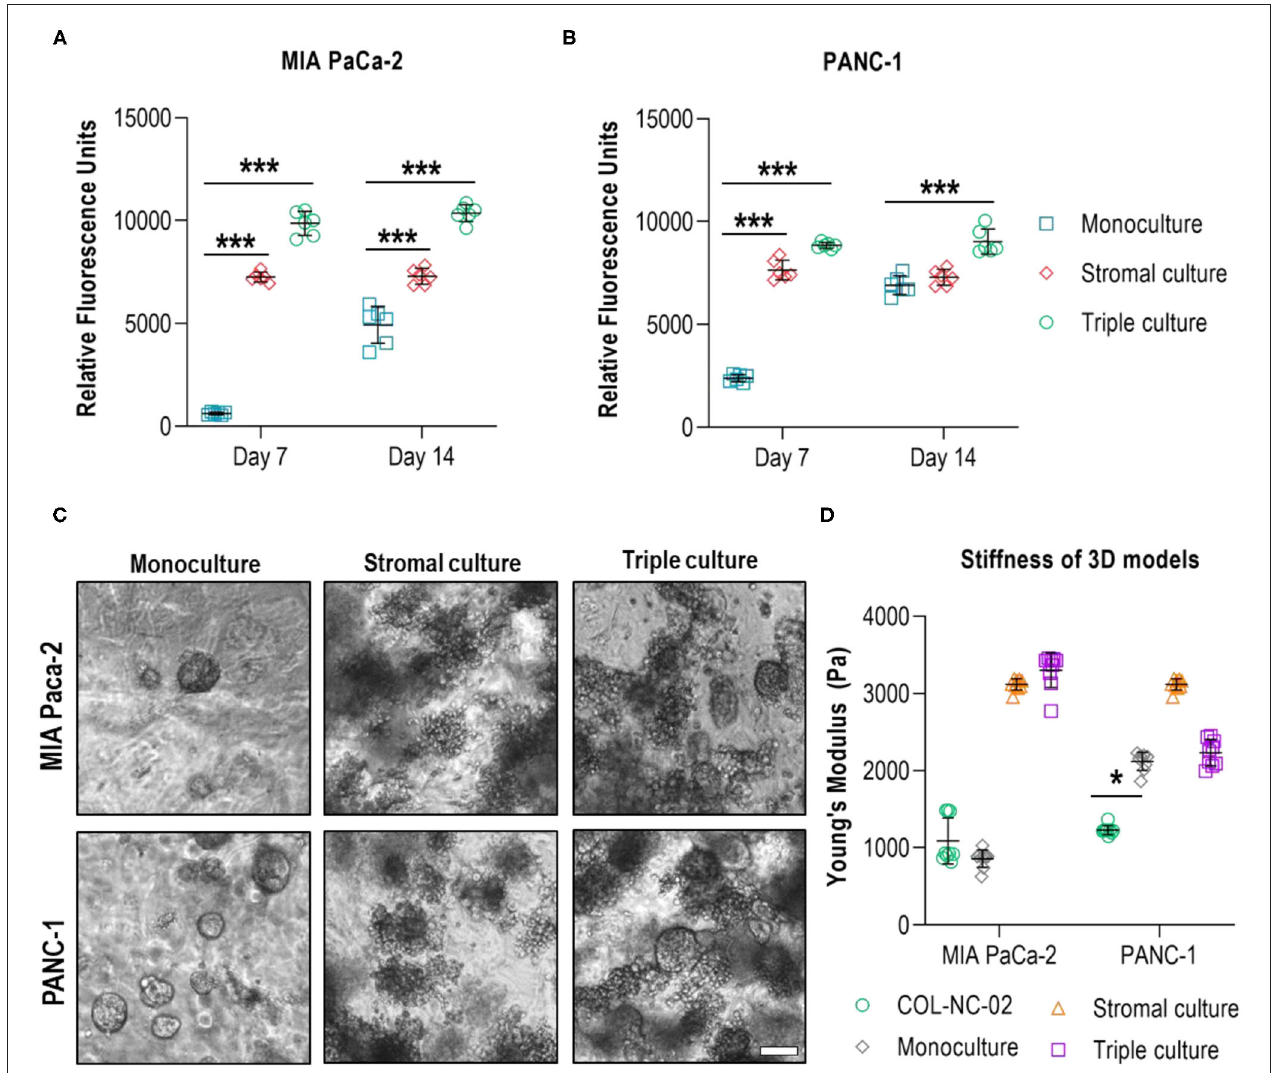
FIGURE 5 | Evaluation of multicellular 3D cultures of tumour spheroids with stromal cells. The metabolic activity of MIA PaCa-2 (A) and PANC-1 (B) cell monocultures was initially lower than in the stromal and triple cultures in the collagen-nanocellulose matrices and increased over time. (C) Fewer spheroids were formed by MIA PaCa-2 cells in both 3D culture settings, while more spheroids were formed by PANC-1 cells. (D) The Young’s moduli of the MIA PaCa-2 and PANC-1 triple cultures reached 3,303 ± 226Pa and 2,233 ± 172Pa, respectively. Results shown represent independent experiments performed in triplicates ( n = 3, error bars = SD). Scale bar = 100 µ